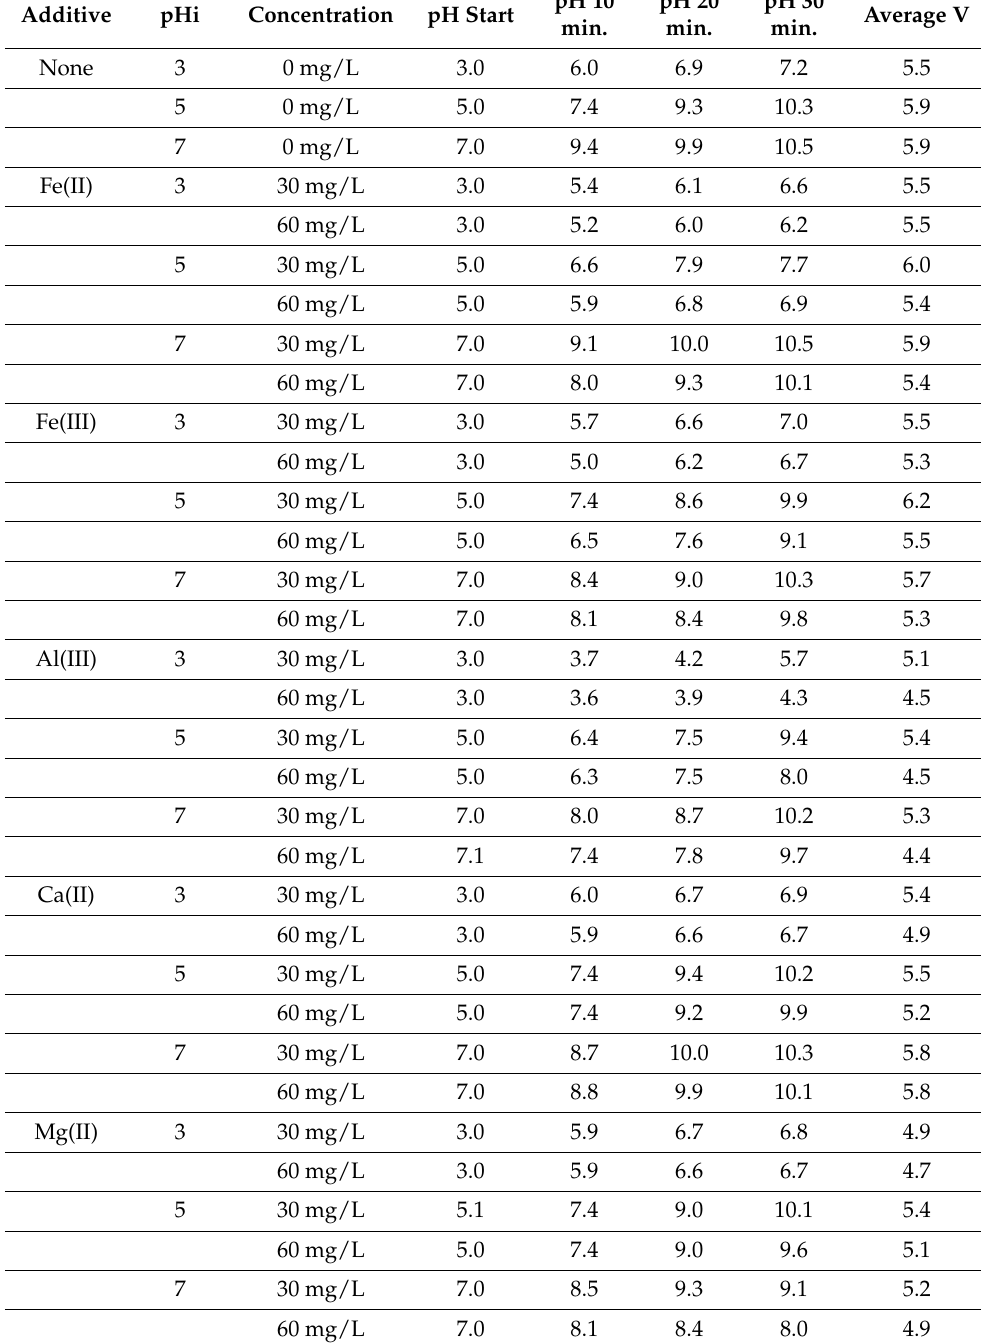
Table 1. pH over time and average voltage during